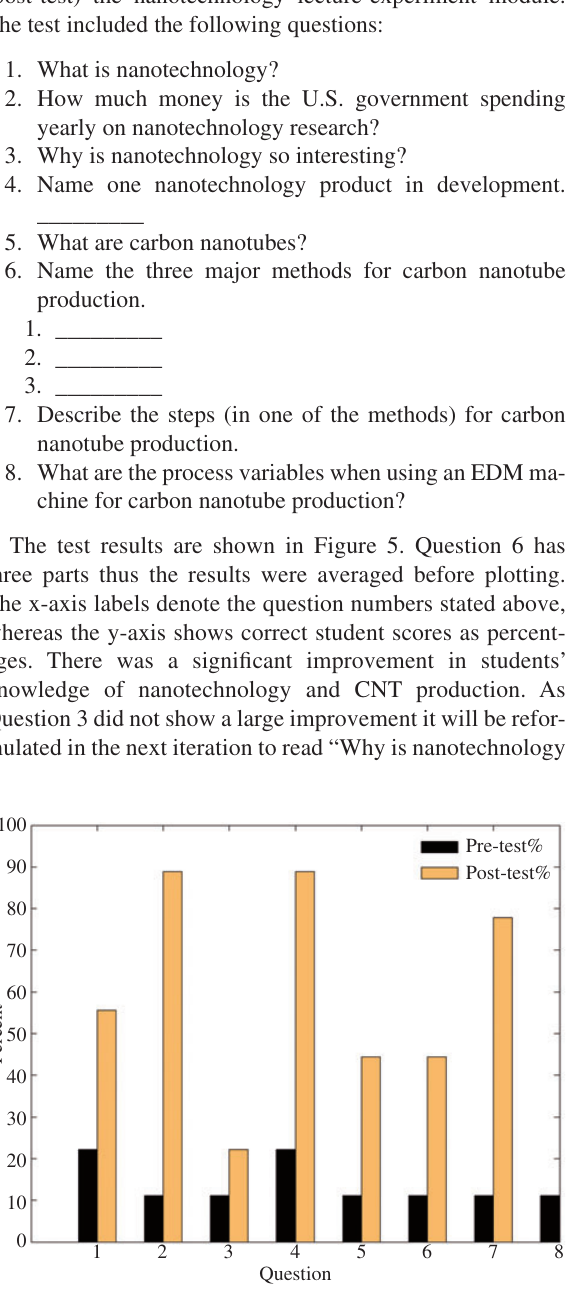
Figure 5 Pre- and post-test